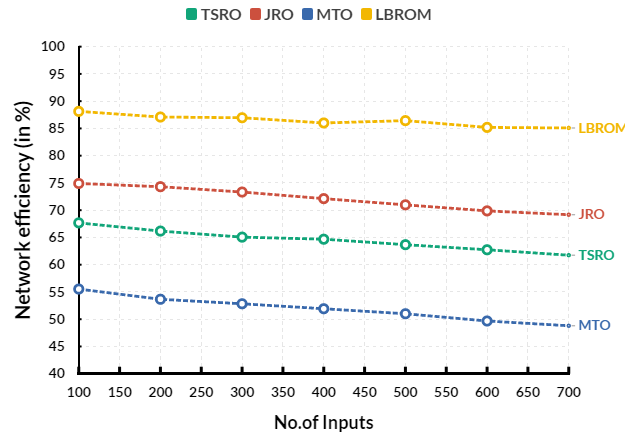
Figure 3. Comparison of network efficiency.